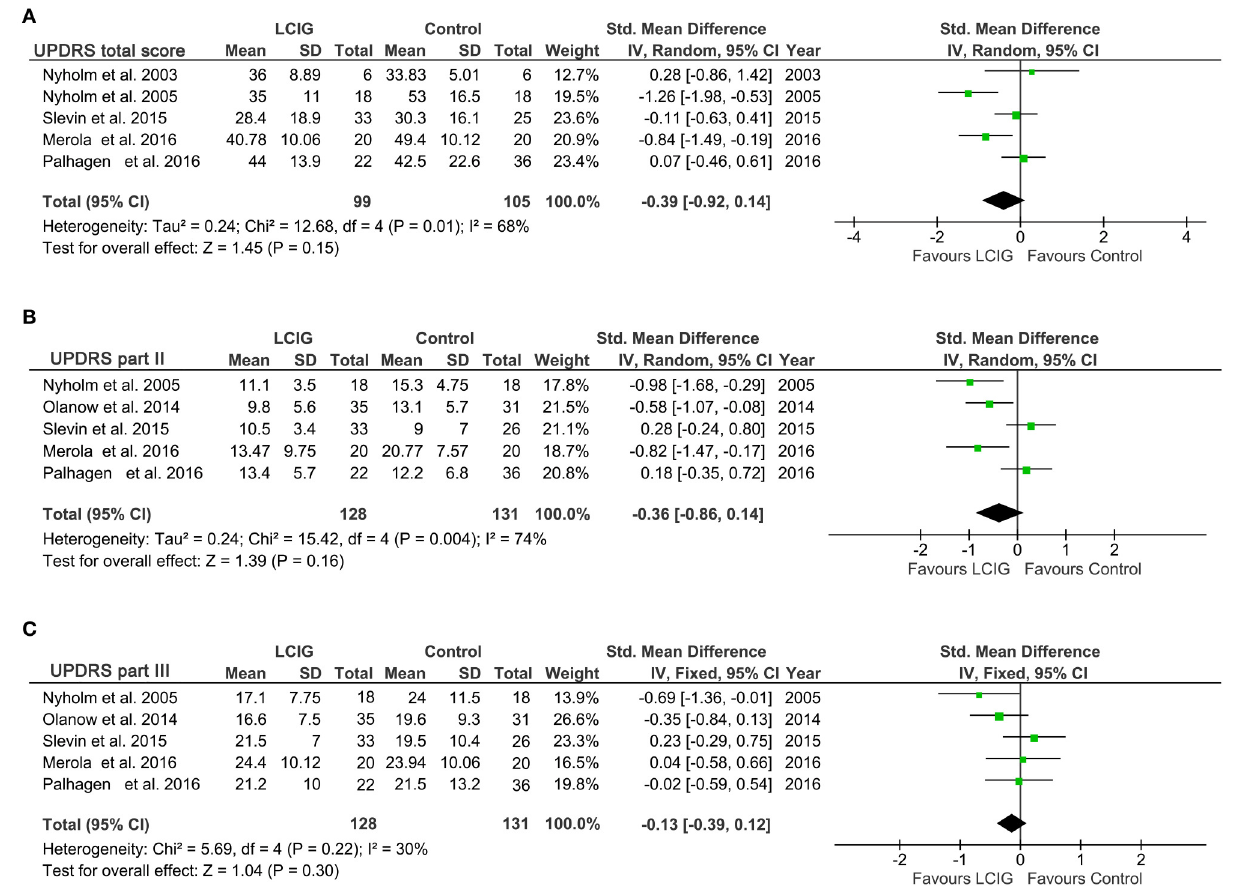
FIGURE 3 | Forest plots of pooled UPDRS scores in PD patients. Plot A (A) , UPDRS total scores; plot B (B) , UPDRS part II; plot C (C) , UPDRS part III. PD, Parkinson’s disease; LCIG, levodopa-carbidopa intestinal gel.